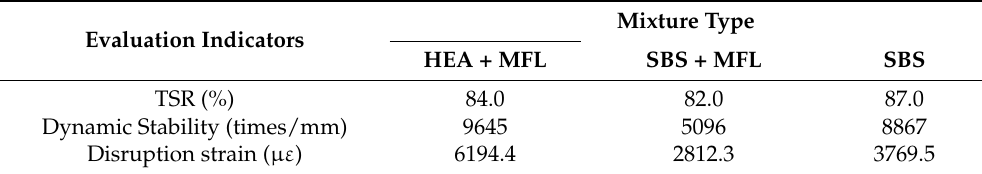
Table 4. Performance improvement of high elasticity modified asphalt on salt storage asphalt mixtures: HEA is high-elasticity asphalt; SBS is styrenic block copolymer.